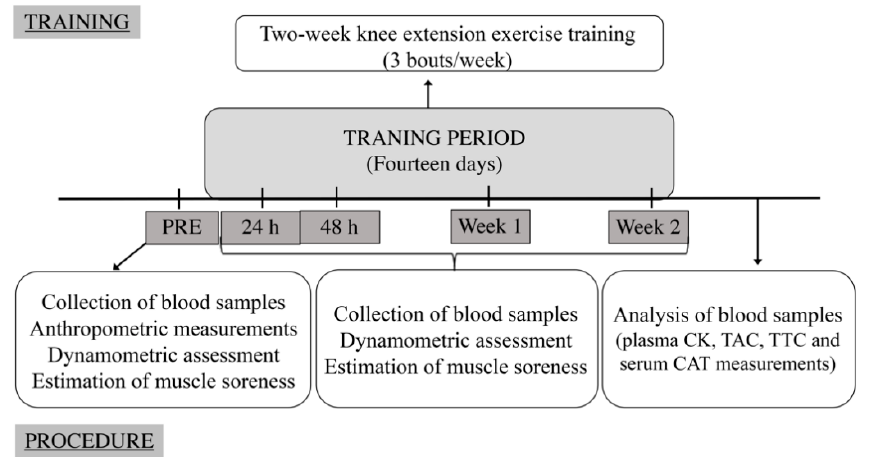
Figure 1. Training and study protocol during the experimental period CK = creatine kinase enzyme activity, TAC = total antioxidant capacity, TTC = total thiol concentration, CAT = catalase enzyme activity.